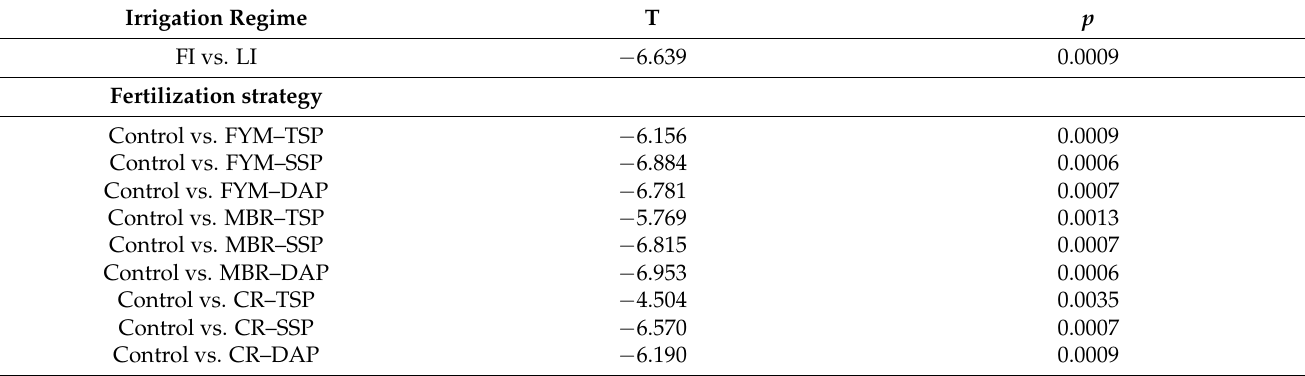
Table 5. Test statistic from the multiresponse permutation procedure (MRPP) for multiple paired comparisons to evaluate the main effects of irrigation management and fertilization sources on wheat plant characteristics. p is the probability of significant differences among selected